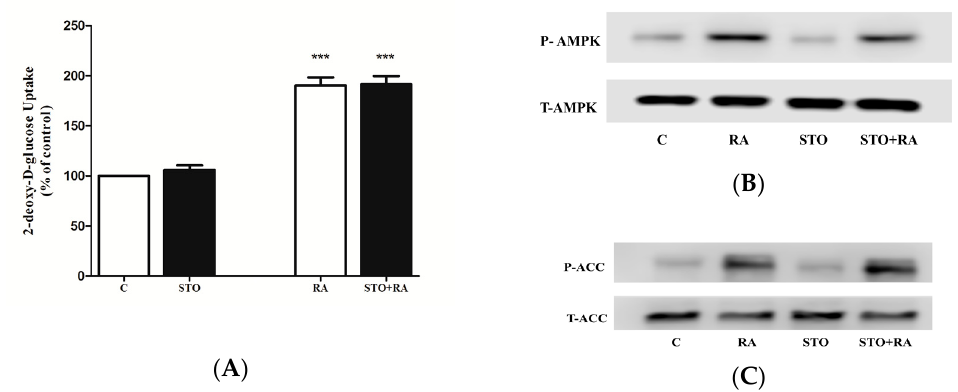
Figure 6. ( A ) Effect of wortmannin (W) on rosmarinic acid (RA)-induced glucose uptake. L6 myotubes Figure 5. ( A ) Effect of STO-609 on rosmarinic acid (RA)-induced glucose transport. L6 myotubes were were incubated in the absence (control, C) or presence of 100 nM wortmannin (W) for 15 min followed incubated in the absence (control, C) or presence of 27 µM STO-609 (STO) for 1 hour followed by the by the addition of 5.0 µ M RA (4 h), 5 µ g/mL of RE (4 h) or 100 nM insulin (30 min) and glucose uptake addition of 5.0 µM RA (4 h) and glucose uptake measurements. Results are the mean ± SE of 3 measurements. Results are the mean SE of 6–7 independent experiments. *** p < 0.001 vs. control. independent experiments. *** p < 0.001 vs control. ### p < 0.001 vs treatment in the absence of STO-609. ### p < 0.001 vs. treatment in the absence of wortmannin. ( B ) and ( C ) Effect of rosmarinic acid (RA) on Akt and P70 S6K phosphorylation. L6 myotubes were treated without (control, C) or with 5.0 µ M RA (2 h), I 100 nM (30 min) or 2 mM metformin (MET) (2 h). Whole-cell lysates were prepared, resolved by SDS-PAGE and immunoblotted with specific antibodies that recognize phosphorylated Akt (P-Akt) or total Akt (T-Akt) ( B ) or phosphorylated p70 S6K (P-p70S6K) or total p70 S6K (T-p70S6K) ( C